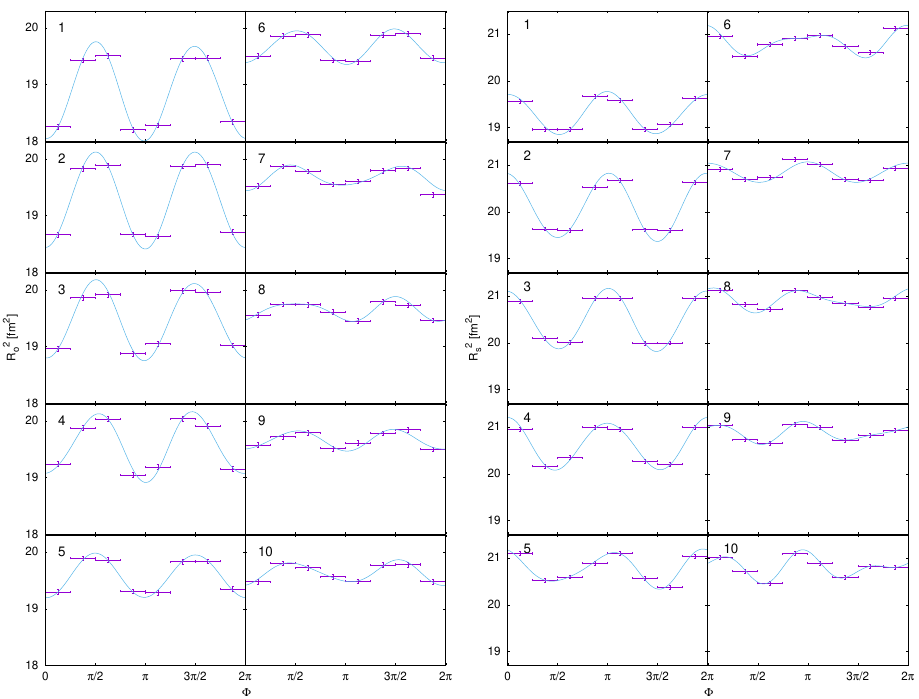
Figure 3. Dependences of the correlation radii on the azimuthal angle, as they result from simulations with DRAGON. Plotted are R 2 (left) and R 2 (right) and di ff erent panels show di ff erent event bins, as o s indicated by the event bin number in each